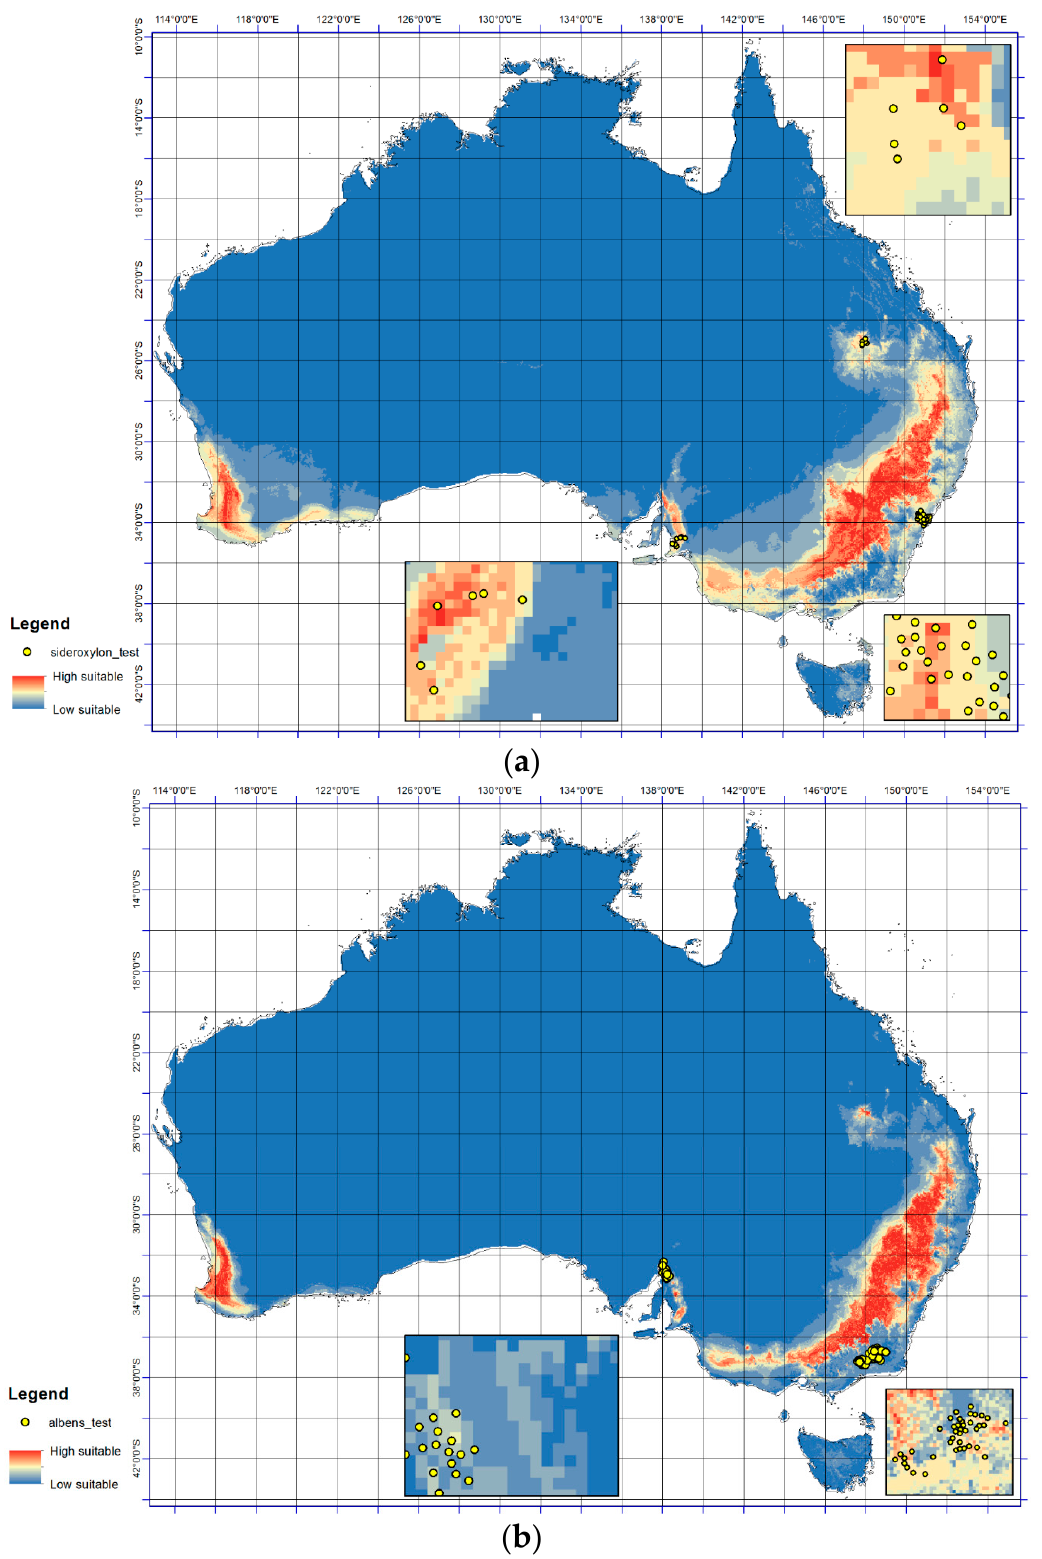
Figure 2. The testing point response surfaces at continental and enlarged scale for ( a ) E. sideroxylon and ( b ) E. albens . The lowest (most unsuitable) predicted occurrence probability is indicated by the cool colors and the optimal range by the warmer color.